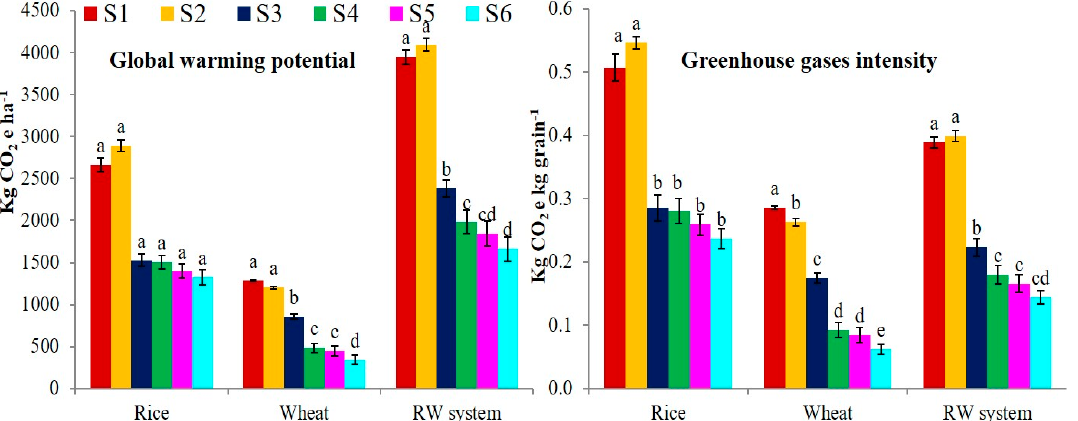
Figure 3. Mean annual global warming potential (GWP) and greenhouse gases intensity of rice-wheat system under divergent crop management scenarios. S1- Conventional tillage (CT) without residue; S2- CT with residue, S3- Reduced tillage (RT) with residue + Recommended dose of fertilizer (RDF); S4- RT/zero tillage (ZT) with residue + RDF, S5-ZT with residue + RDF + green seeker + tensiometer + Information & communication technology + crop insurance and S6- S5 + site specific nutrient management. Values with different lower case (a–e) letters are significantly different between each scenario at 5% level of significance ( p ≤ 0.05). Vertical bars indicate ±S.E. of mean of the observed values.